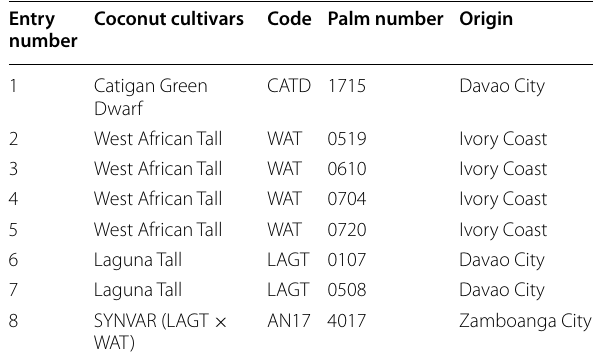
Table 1 Coconut genotypes used in the study for screening the SSR